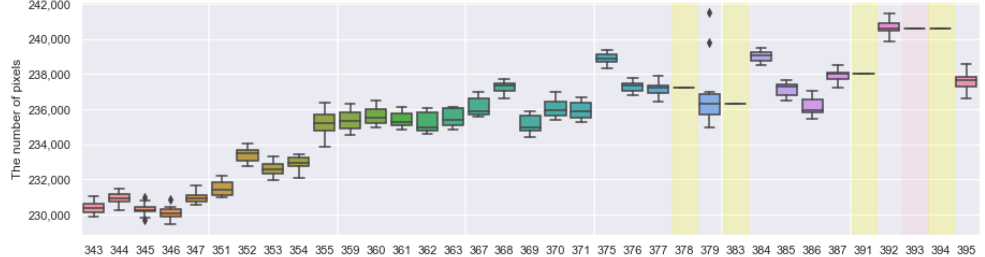
Figure A6. 17–23 September.